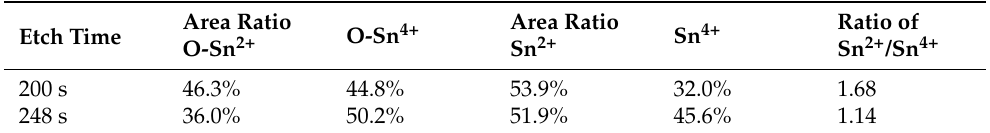
Figure 1. ( a ) The schematic image of ITO/SnO X /TaN device and FE-SEM image includes the thick- ness information of each layer. The O 1s core-level spectra of ( b ) ITO/SnO X interface and ( c ) SnO X /TaN interface. The Sn 3d 5/2 core level spectra of ( d ) ITO/SnO X interface and ( e ) SnO X /TaN in- terface. The XPS analysis was conducted through the Shirley background and GL(10). Table 1. Percentage of oxygen – tin bonds in ITO/SnO X /TaN RRAM device. Area was calculated at Table 1. Percentage of oxygen–tin bonds in ITO/SnO X /TaN RRAM device. Area was calculated at the core level of O 1s and Sn 3d, respectively. the core level of O 1s and Sn 3d, respectively.